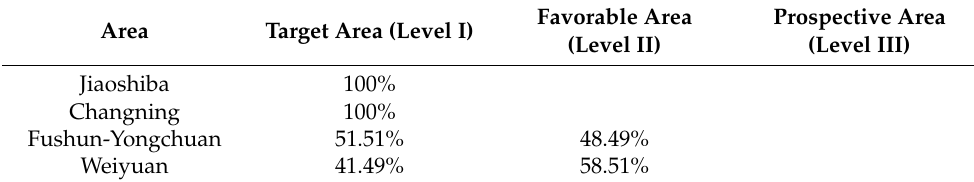
Table 6. Evaluation results of Table